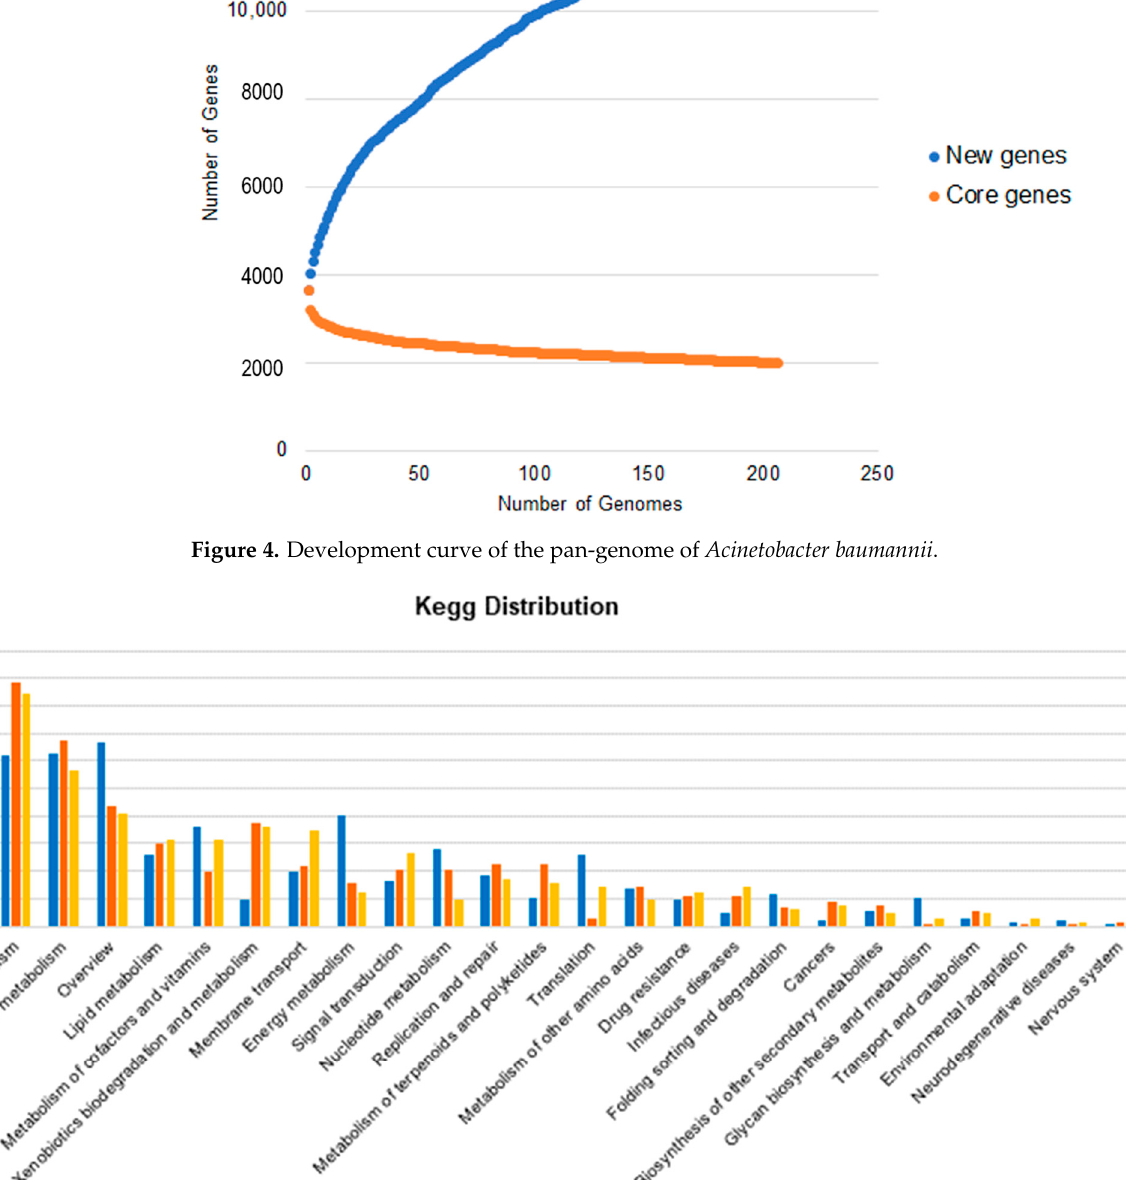
Figure 4. Development curve of the pan-genome of Acinetobacter baumannii .